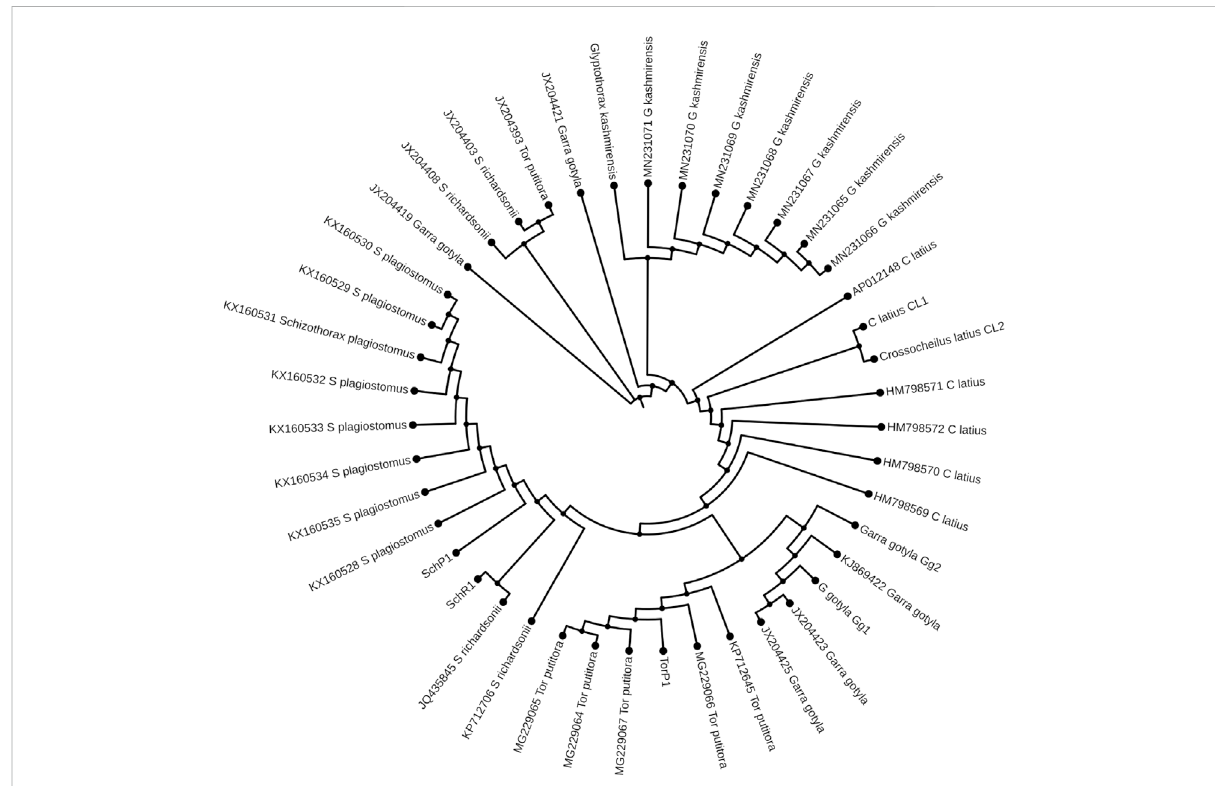
algorithm (parameters — bootstrap value = 100, tree search